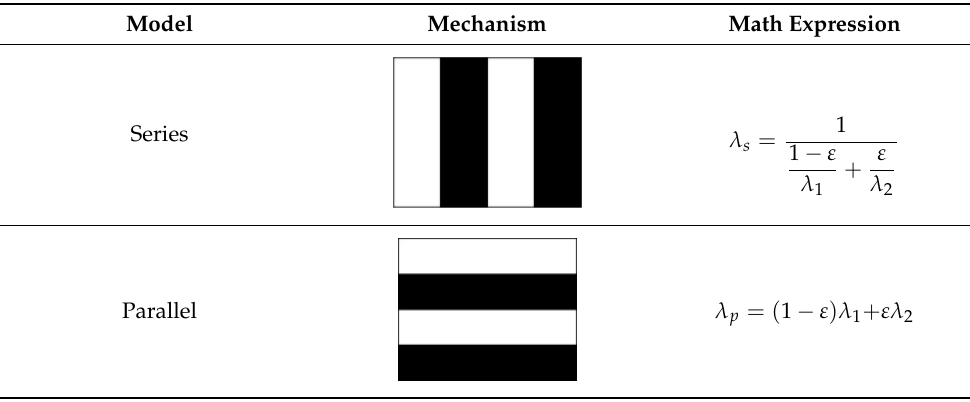
Table 1. Series-parallel model (heat flow direction: left to right).